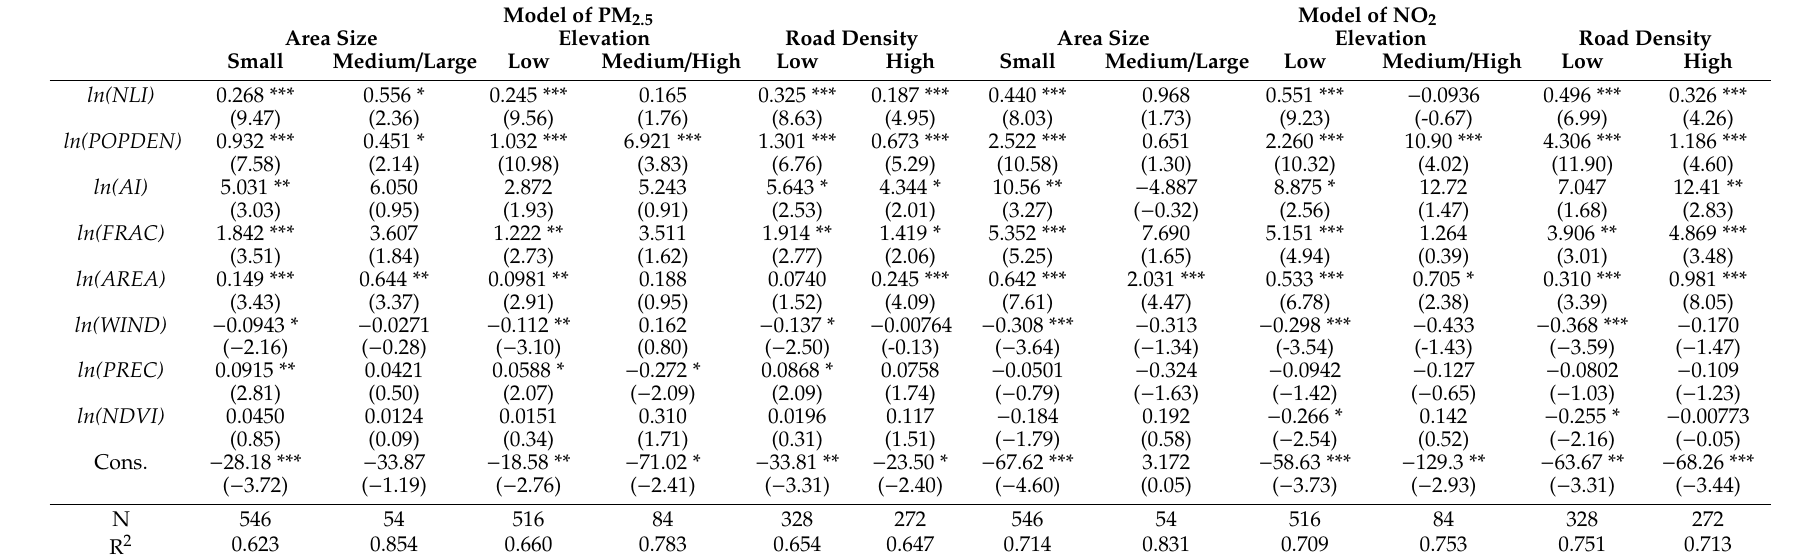
Table A1. Estimations of the FE models of di ff erent sizes, elevations, and road